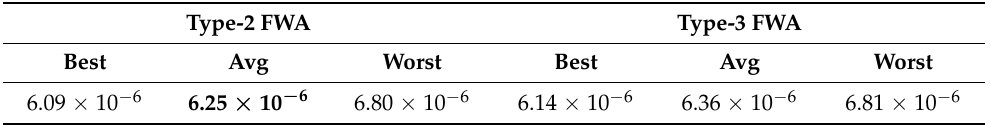
( c ) Figure 23. Type-3 fuzzy input variables (France): ( a ) fuzzy input #1; ( b ) fuzzy input #2; ( c ) fuzzy input #3. In Figure 24, the average convergence obtained by both integration techniques of the 30 runs for France is shown, where the behavior with the type-2 FWA has better convergence than the type-3 FWA (testing set).